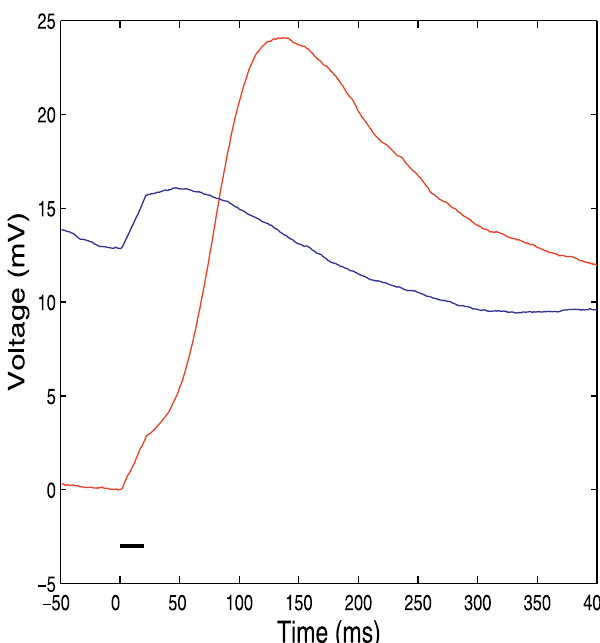
Figure 5. Average Response to a Brief Excitatory Pulse Which Produces a Small Depolarization in Each State The average voltage response is computed. The blue curve shows the response in the Down state. The red curve shows the response in the Up state. The horizontal black bar indicates the duration of the stimulus (starting at t ¼ 0 ms). The time response is different in each state, and in agreement with the experimental results of [27]. DOI: